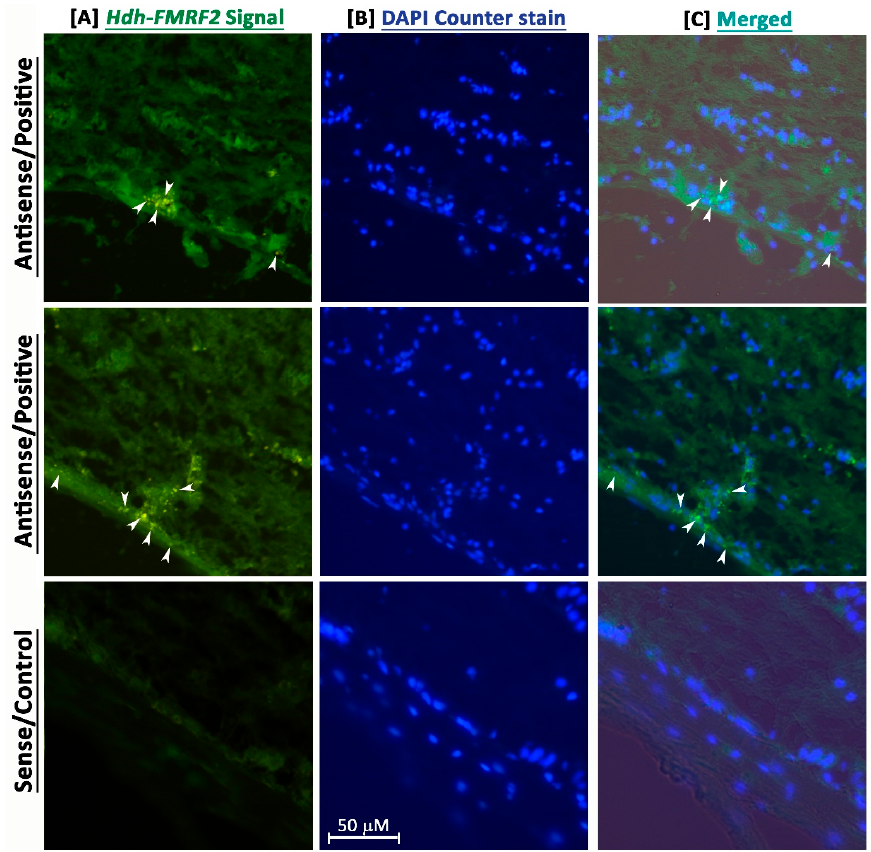
Figure 6. Confocal laser microscopic image of fluorescence in situ hybridization (FISH) of Hdh-FMRF2 mRNA in the cerebral ganglion of adult Pacific abalone. ( A ) Single confocal optical sections showing positive signal (arrow) of Hdh-FMRF2 mRNA (green) when hybridized with the anti-sense probe (1st and 2nd row) and no hybridization signal when hybridized with sense probe (3rd row) ( B ) The nuclei are counterstained with DAPI (blue). ( C ) Merged image of ( A , B ). Scale bar: 50 µm.